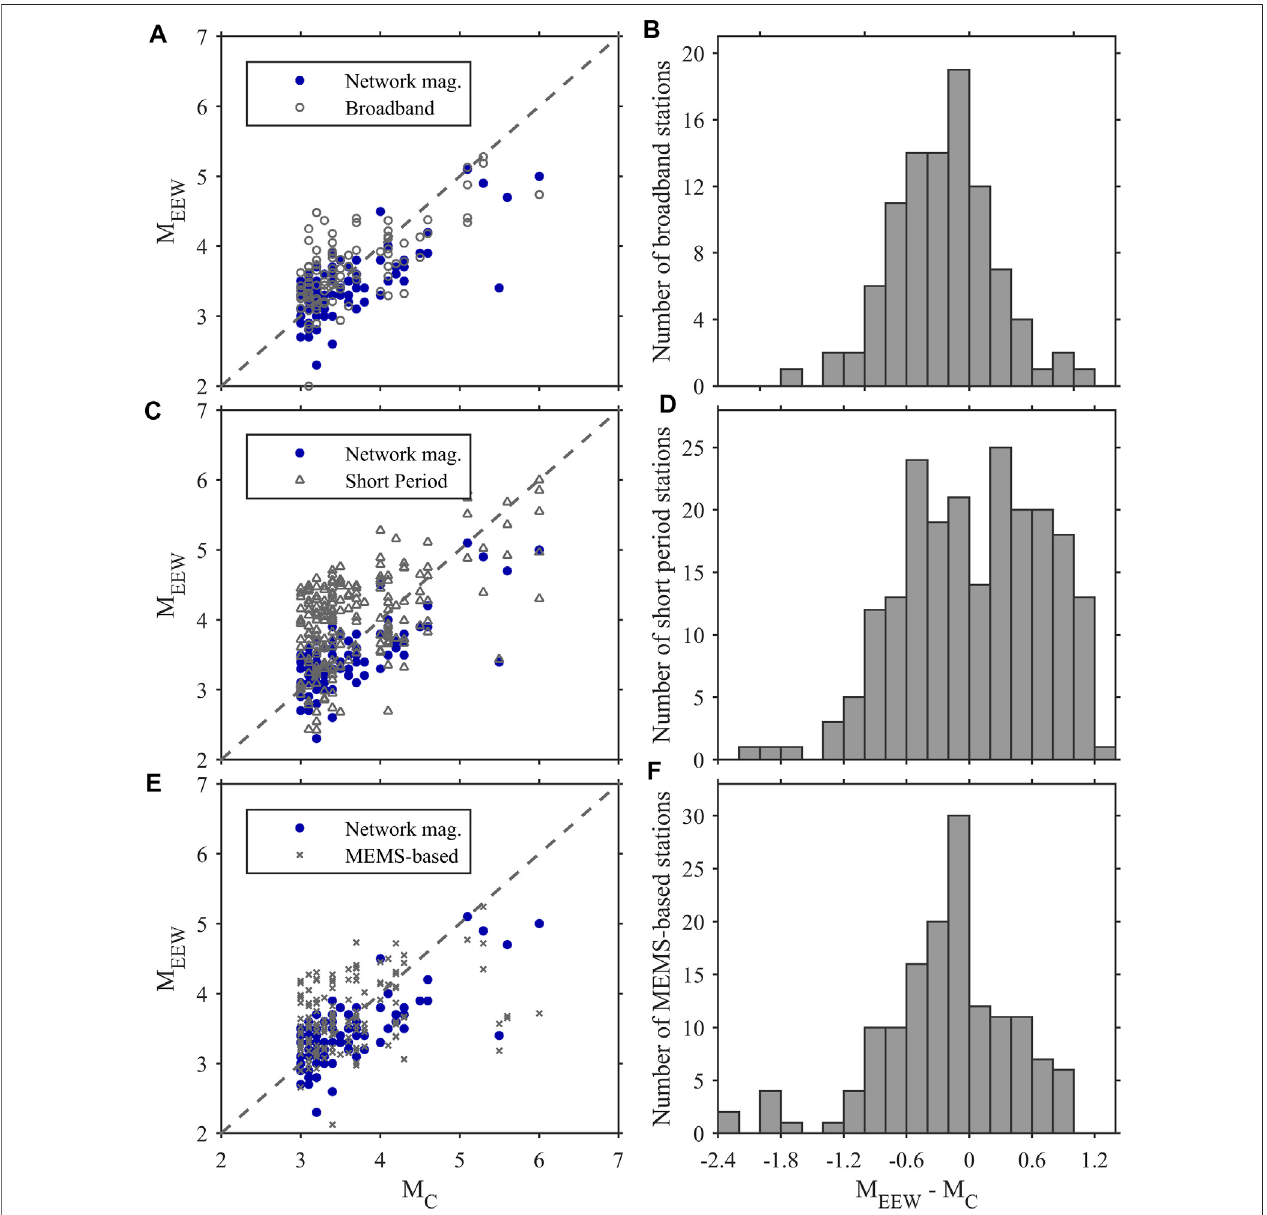
FIGURE 4 | Comparison of the JEEWS magnitudes of the Changning seismic sequence for both stages. (A, C, E) JEEWS vs. the China Earthquake Network Center (CENC) catalogs for different station types. Empty circles, broadband seismic station magnitude; crosses, short period seismic station magnitude; triangles, MEMS-based station magnitude; blue circle, network magnitude. (B, D, F) Histograms of the magnitude differences for different station types.